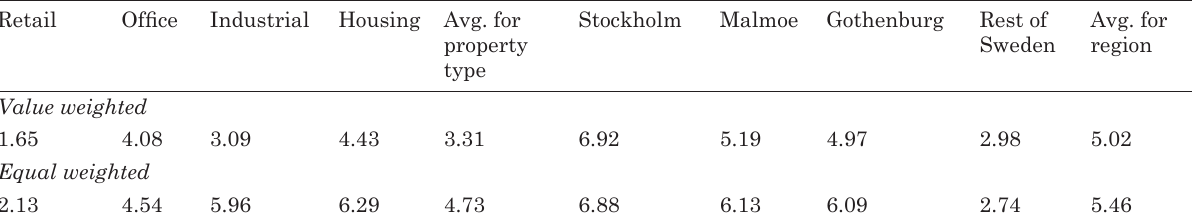
Table 11. absolute average values of property type- and regional coefficients retail